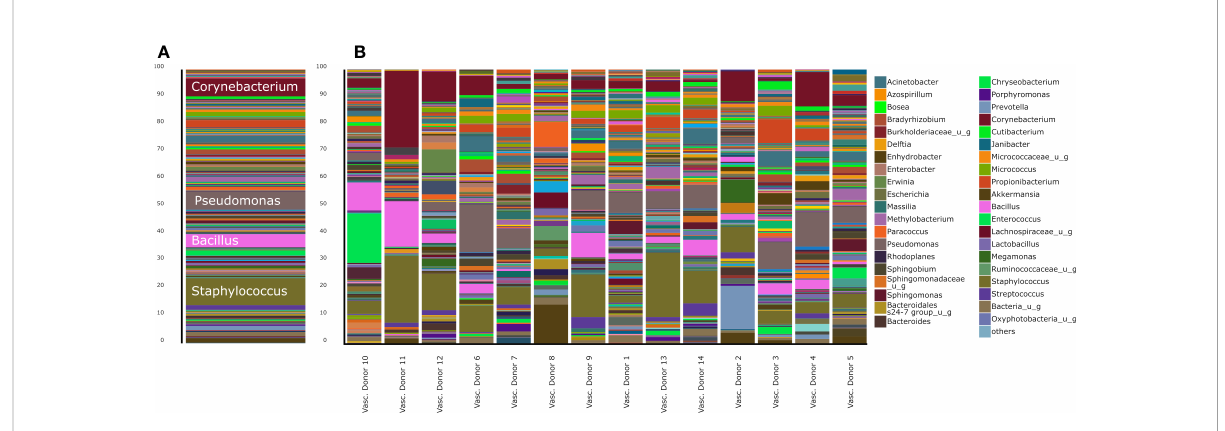
FIGURE 2 Stacked bar representation of human vascular microbiome composition at genus level. (A) , aggregated results and (B) , results of separated